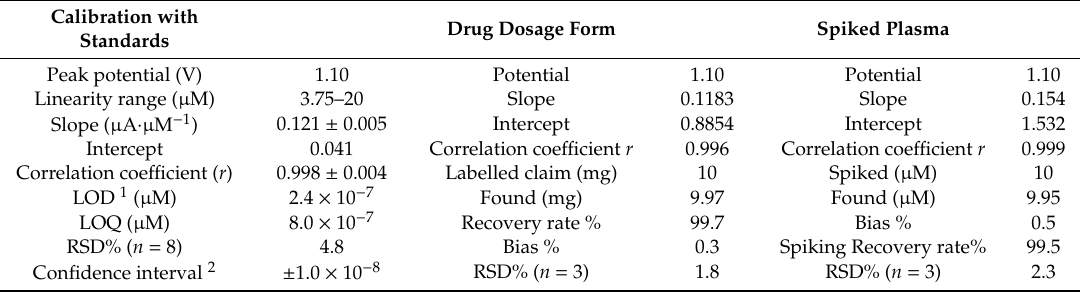
Table 1. The analytical parameters obtained for the calibration of standards, drug dosage form and plasma